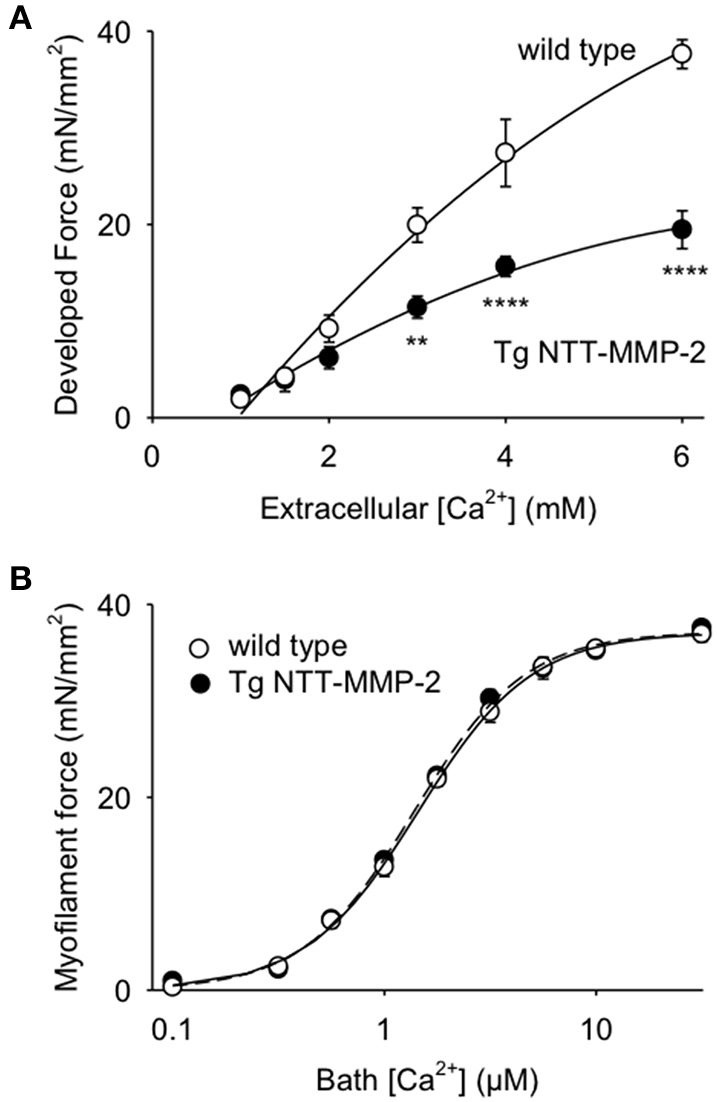
(A) Relationship between developed force vs. bath [Ca2+] for electrically stimulated intact trabeculae. Trabeculae from transgenic (Tg) NTT-MMP-2 mice developed less force with raised bath [Ca2+] compared to wild type controls (P < 0.001, ANOVA; mean ± SE, n = 4/group, **P < 0.01, ****P < 0.0001). (B) Relationship between steady-state force development and [Ca2+] for skinned trabeculae (error bars were less than the symbol size). There was no statistical difference in myofilament force development of trabeculae from wild type vs. Tg NTT-MMP-2 mice (Two-Way ANOVA), thus, expression of NTT-MMP-2 did not reduce myofilament force in skinned myocardium. Lines show fitting of the pooled data to the Hill equation.